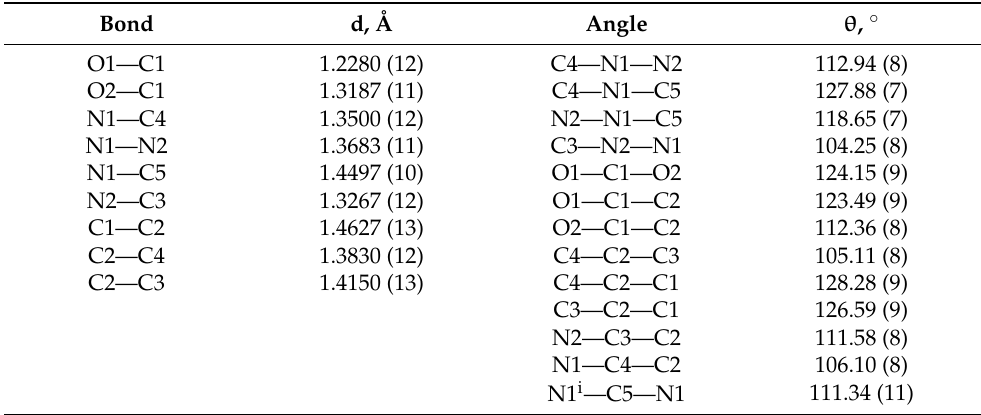
Table 1. Selected geometric parameters of the molecular structure of H 2